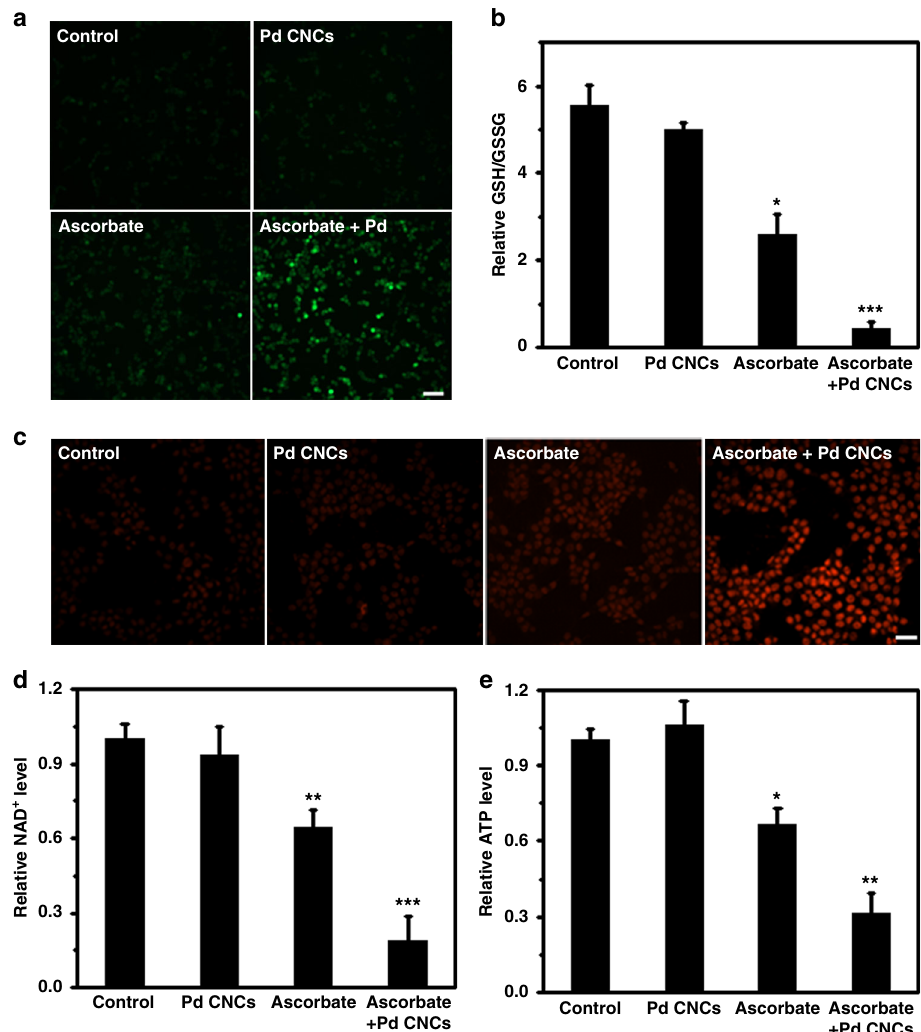
Fig. 6 Mechanisms of ascorbate-induced cytotoxicity enhanced by Pd CNCs. a Representative fl uorescence images of intracellular ROS levels stained with DCFH-DA probes. HCT116 cells were respectively treated with 2 mM ascorbate, 50 μ g/mL Pd CNCs, or combined ascorbate/Pd CNCs. Scale bar: 70 μ m. b Relative ratios of reduced to oxidized glutathione (GSH/GSSG) in HCT116 cells after various treatments. c Representative fl uorescence images of fragmented DNA in HCT116 cells after various treatments using the TUNEL assay. Scale bar: 35 μ m. d Changes in NAD + levels. e ATP levels in HCT116 cells after various treatments. Error bars were taken from three parallel experiments ( n = 3). P values compared to that of corresponding PBS-treated cells were calculated by Student´s t -test: * p < 0.05, ** p < 0.01 and *** p < 0.001